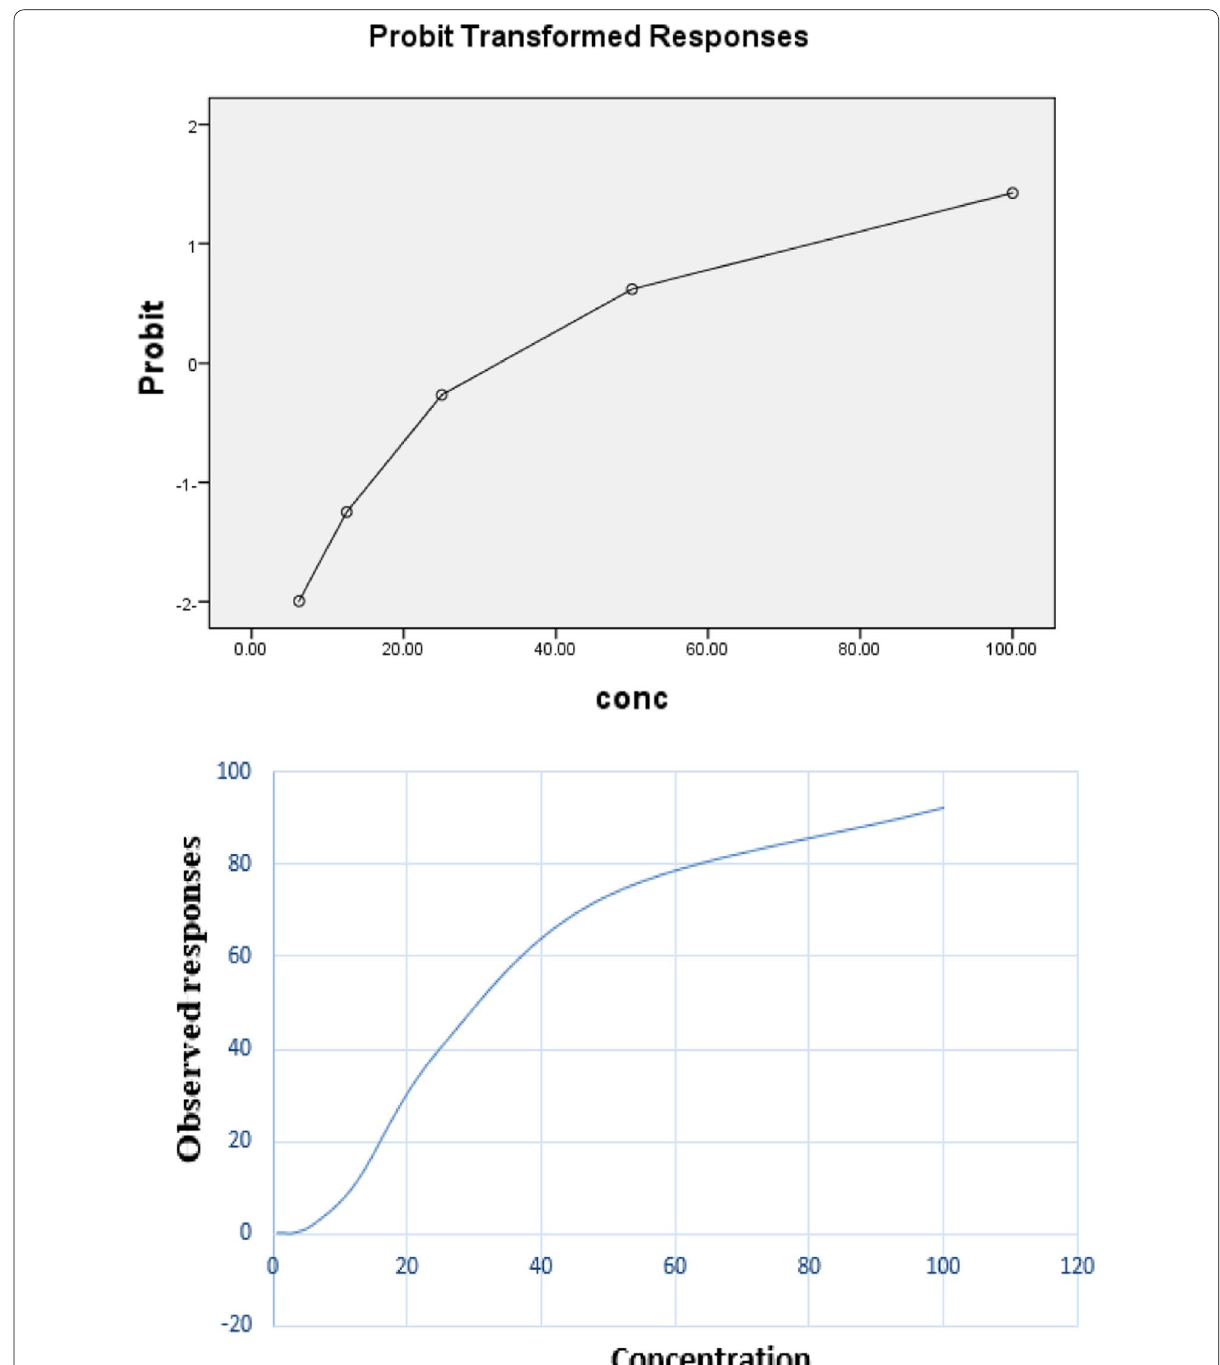
Fig. 3 Cytotoxic effect of the methanolic extract of S. mahagoni (L.)